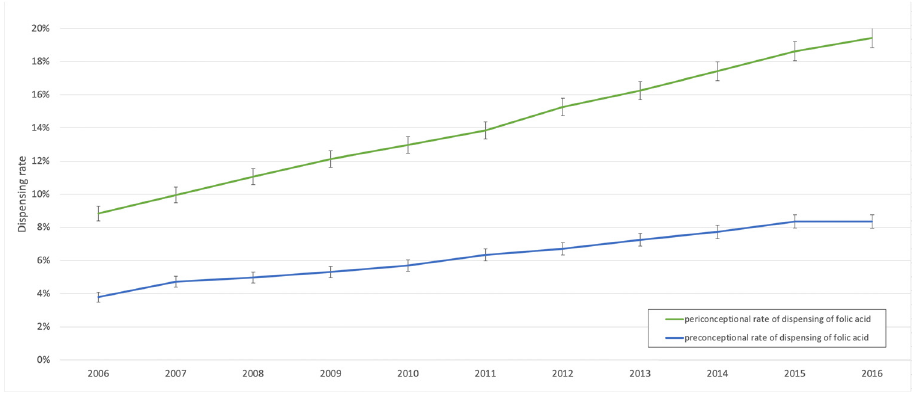
Figure 1. Annual rate of dispensing of folic acid in the preconceptional and periconceptional periods from 2006 to 2016, in a sample representative of the French population including 186,061 pregnancies.